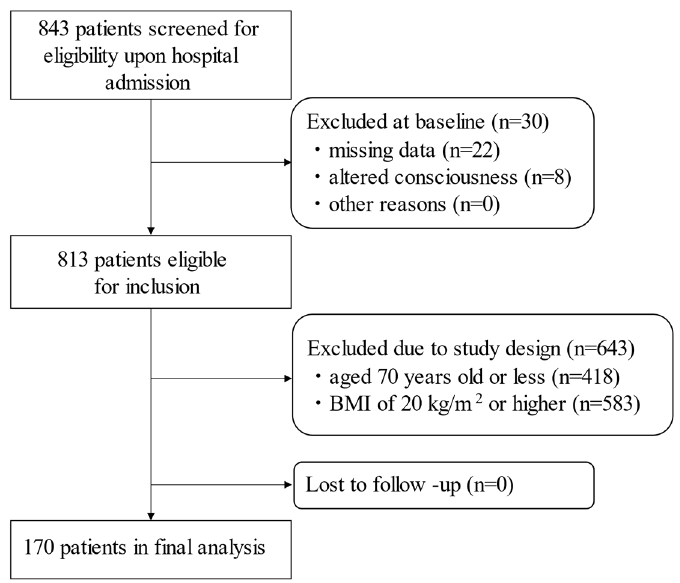
Figure 1. Flowchart of participant screening, inclusion criteria, and follow-up. The patients’ baseline characteristics are presented in Table 1. The mean age was 83.1 ± 6.2 years; 52% of the patients were male. The median BW and SMM were 41.6 kg (IQR: 38.2–44.1) and 10.9 kg (IQR: 8.8–13.2), respectively. The median MNA-SF was 4 (IQR: 3–